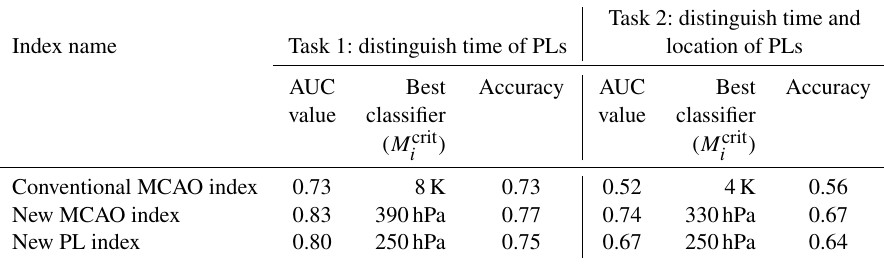
Figure 7. ROC curves for distinguishing times and locations of PLs based on conventional and new diagnostic indices. Panels: (a) task 1: distinguish the time of PL events and (b) task 2: distinguish the time and location of PL events. Index scores are compared with the times and locations of observed PLs, as reported in the STARS data (Noer et al., 2011; STARS-DAT, 2013), by testing a set of critical thresholds (Eq. 6), for distinguishing areas and times at risk for polar lows. Diagnostic indices: the conventional MCAO index (Eq. 1), the new MCAO index (Eq. 3), and the new polar low index (Eq. 4). The critical thresholds highlighted in black are the best classifiers, defined as the thresholds M crit (Eq. 6) that maximize Youden’s index (Youden, 1950). These are used for calculating the accuracy of indices in distinguishing times i and areas of PLs (see text and Table 2). Table 2. Performance metrics for distinguishing times and locations of PLs based on simple diagnostic indices. The AUC (area under the curve) values are computed for the ROC curves shown in Fig. 7. The accuracy scores are calculated for the best classifier for each index and task, defined as the classifier that maximizes Youden’s